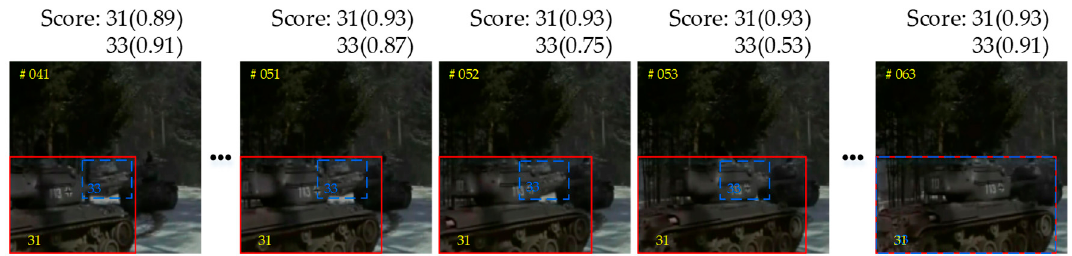
Figure 9. An example of drift caused by occlusion without the Temporal Attention Model.